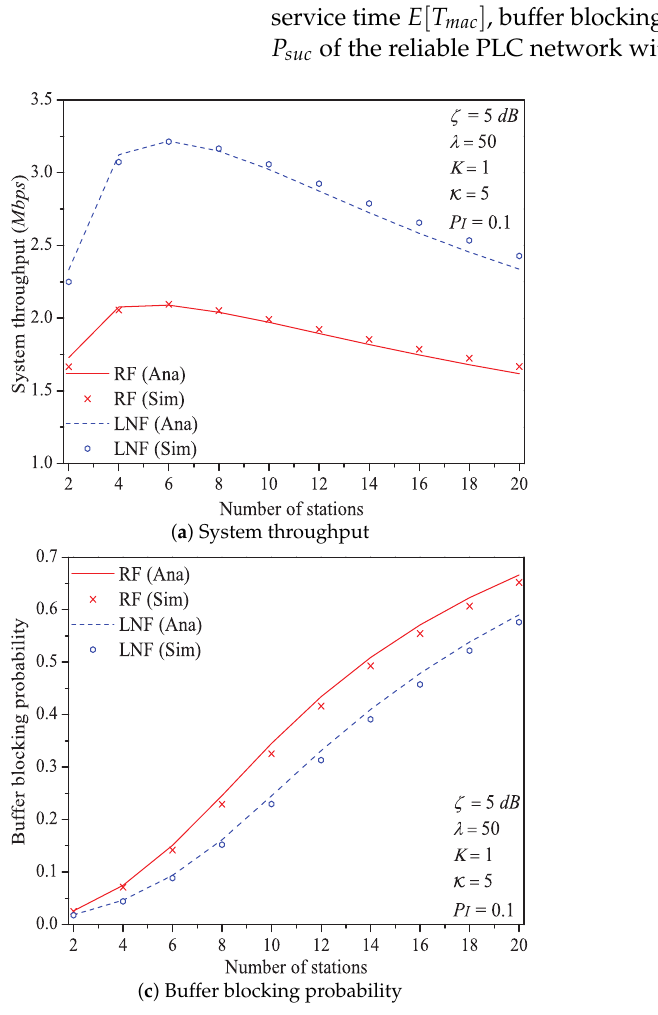
Figure 5. The MAC performance of 1901 protocol with different N